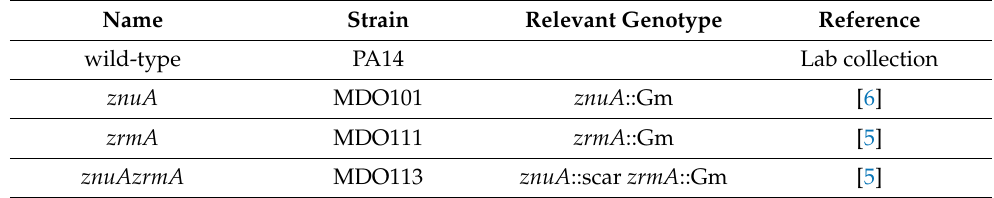
Table 1. P. aeruginosa strains used in this